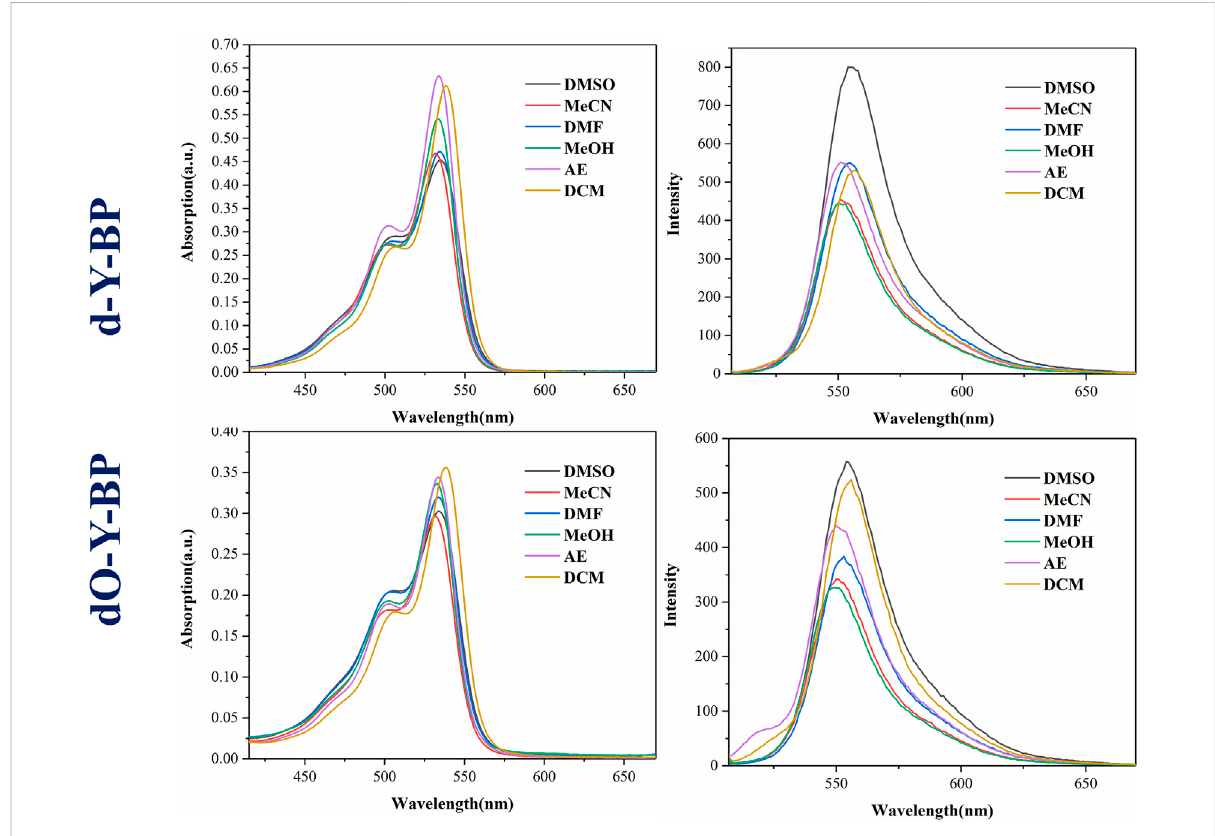
FIGURE 1 Effect of different solvents on photophysical properties of d/dO-Y-BP